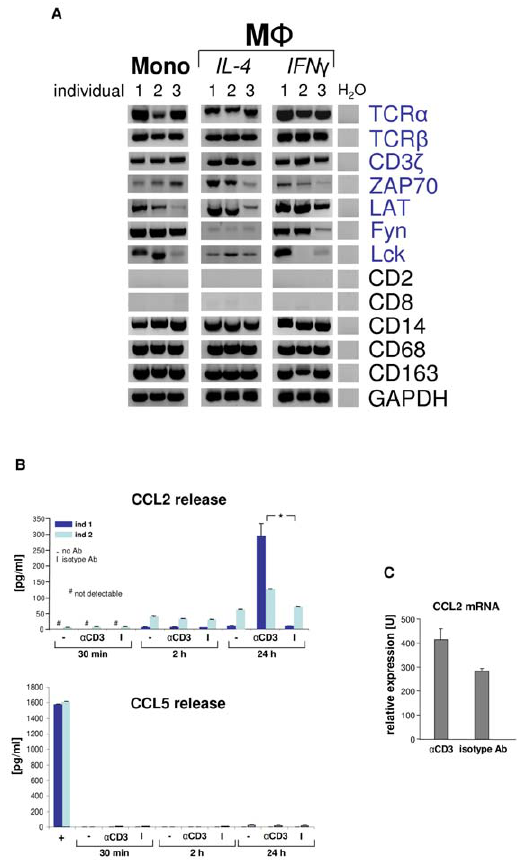
Figure 3. Engagement of the macrophage TCR ab induces CCL2 release. (A) Circulating human monocytes (Mono), IL-4 activated and IFN c activated macrophages (M W ), respectively, constitutively express the genes for the TCR ab chains and integral components of the TCR signalling complex (CD3 f , ZAP70, LAT, Fyn, Lck). RT-PCR profiling is shown for three representative healthy individuals (1–3). Expression of T cell (CD2, CD8) and monocyte/macrophage marker genes (CD14, CD68, CD163) are demonstrated as reference. Peripheral blood monocytes were isolated by CD14-MACS and differentiation into Th1 (IFN c ) and Th2 (IL-4) polarized M W was induced for 6 days. ZAP70, CD3 f associated protein kinase 70; LAT, linker for T cell activation; Fyn, Lck, src family tyrosine kinases; H 2 O, negative control. ( B ) CD3 mediated TCR activation induces selective CCL2 release from macrophages. Aliquots of 5 6 10 5 IFN c macrophages were incubated with soluble antibodies to CD3, isotype control antibodies (I) or in the absence of antibodies (-) for the indicated timepoints. CCL2 and 14 additional cytokines (Table S1) were determined in the supernatant by multiplex cytokine assay. The near absence of the T cell secretory protein CCL5 documents that macrophages were virtually free of T lymphocytes (bottom). Macro- phages were collected from two healthy donors (ind 1, ind 2). + , CD3 + T cells (positive control). *p , 0.05. ( C ) TCR engagement upregulates CCL2 gene expression in macrophages as assessed by quantitative RT-PCR (qPCR). The results shown represent the qPCR analysis of IFN c macrophages from three healthy donors that were stimulated with anti-CD3 antibodies for 24 h.